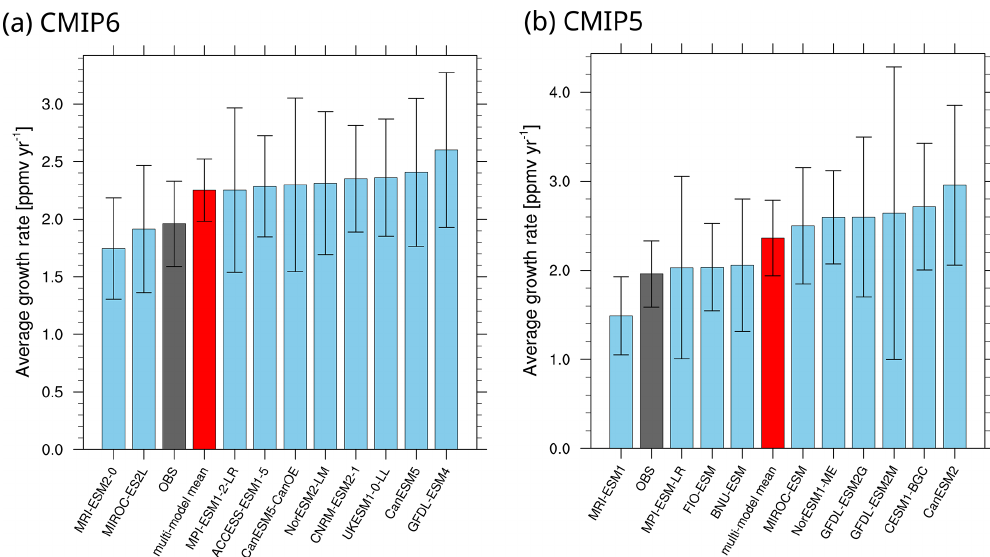
Figure 4. Global mean and standard deviation over all years of annual growth rate of XCO 2 during 2003–2014 for CMIP6 models (a) and CMIP5 models (b) . The black bar represents the satellite observations, while the red bar depicts the multi-model